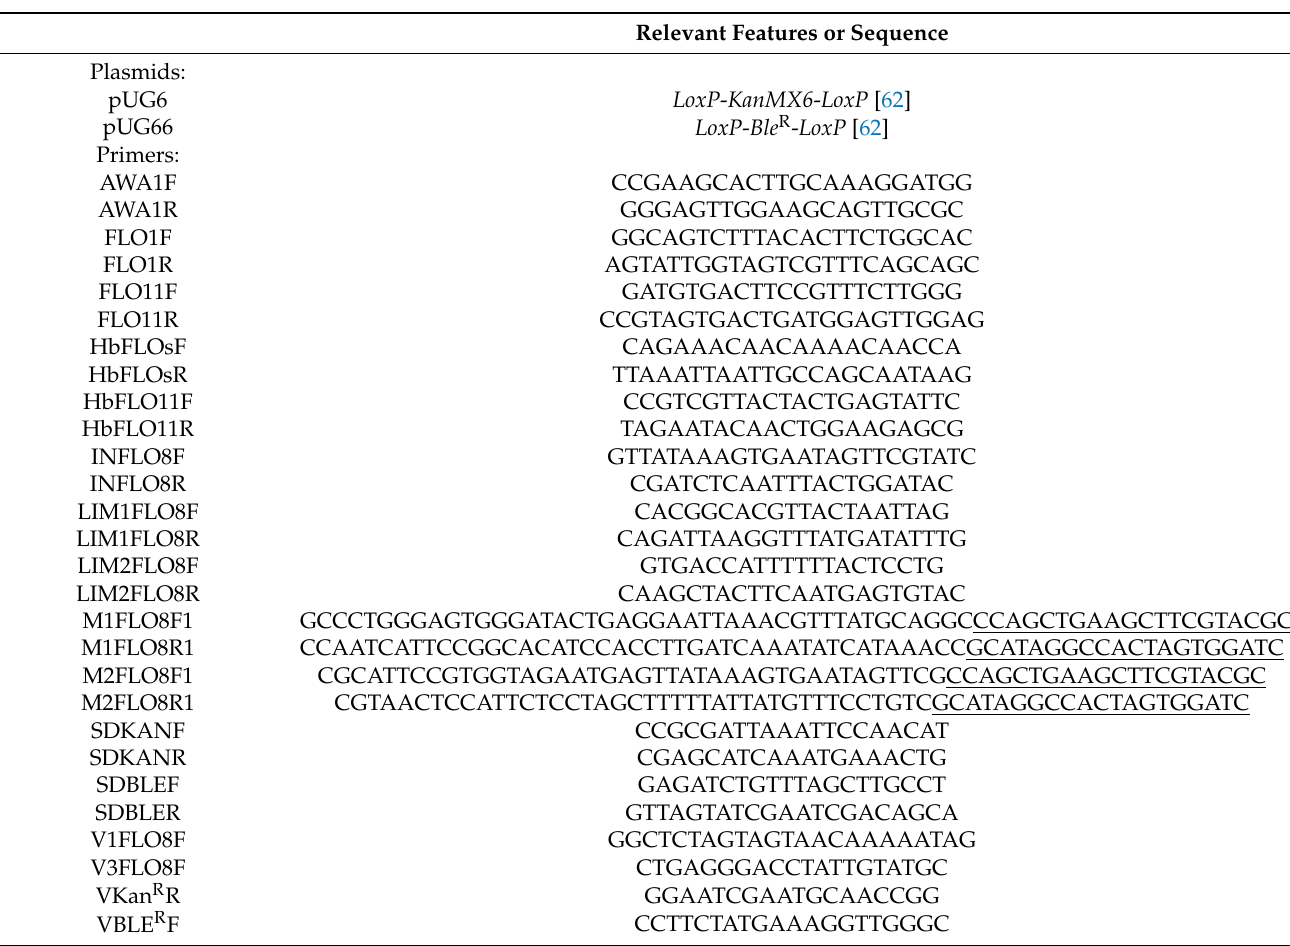
Table 1. Plasmids and primers used in this